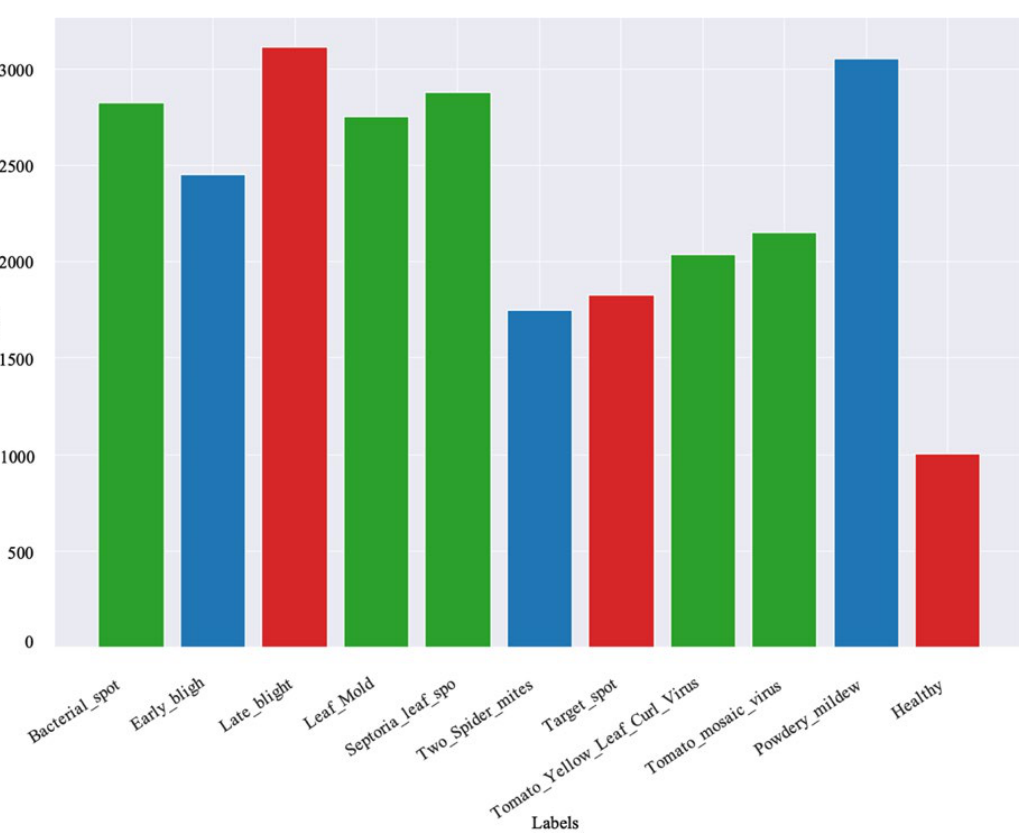
Figure 5. Image distribution per class in the training set.